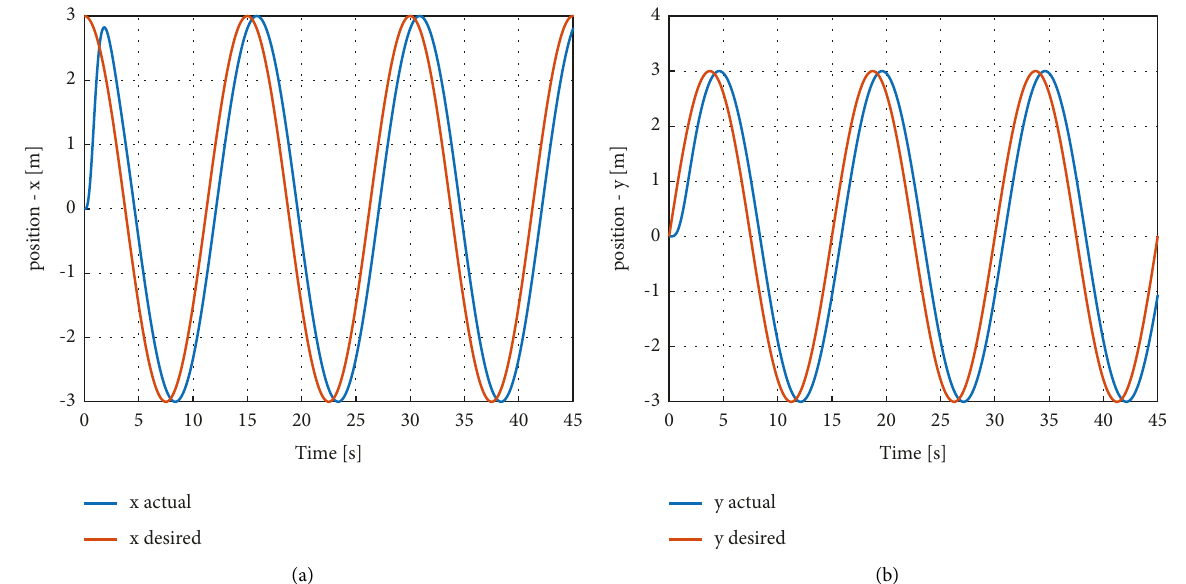
Figure 16: Coordinate-wise comparison between desired and actual trajectories of Figure